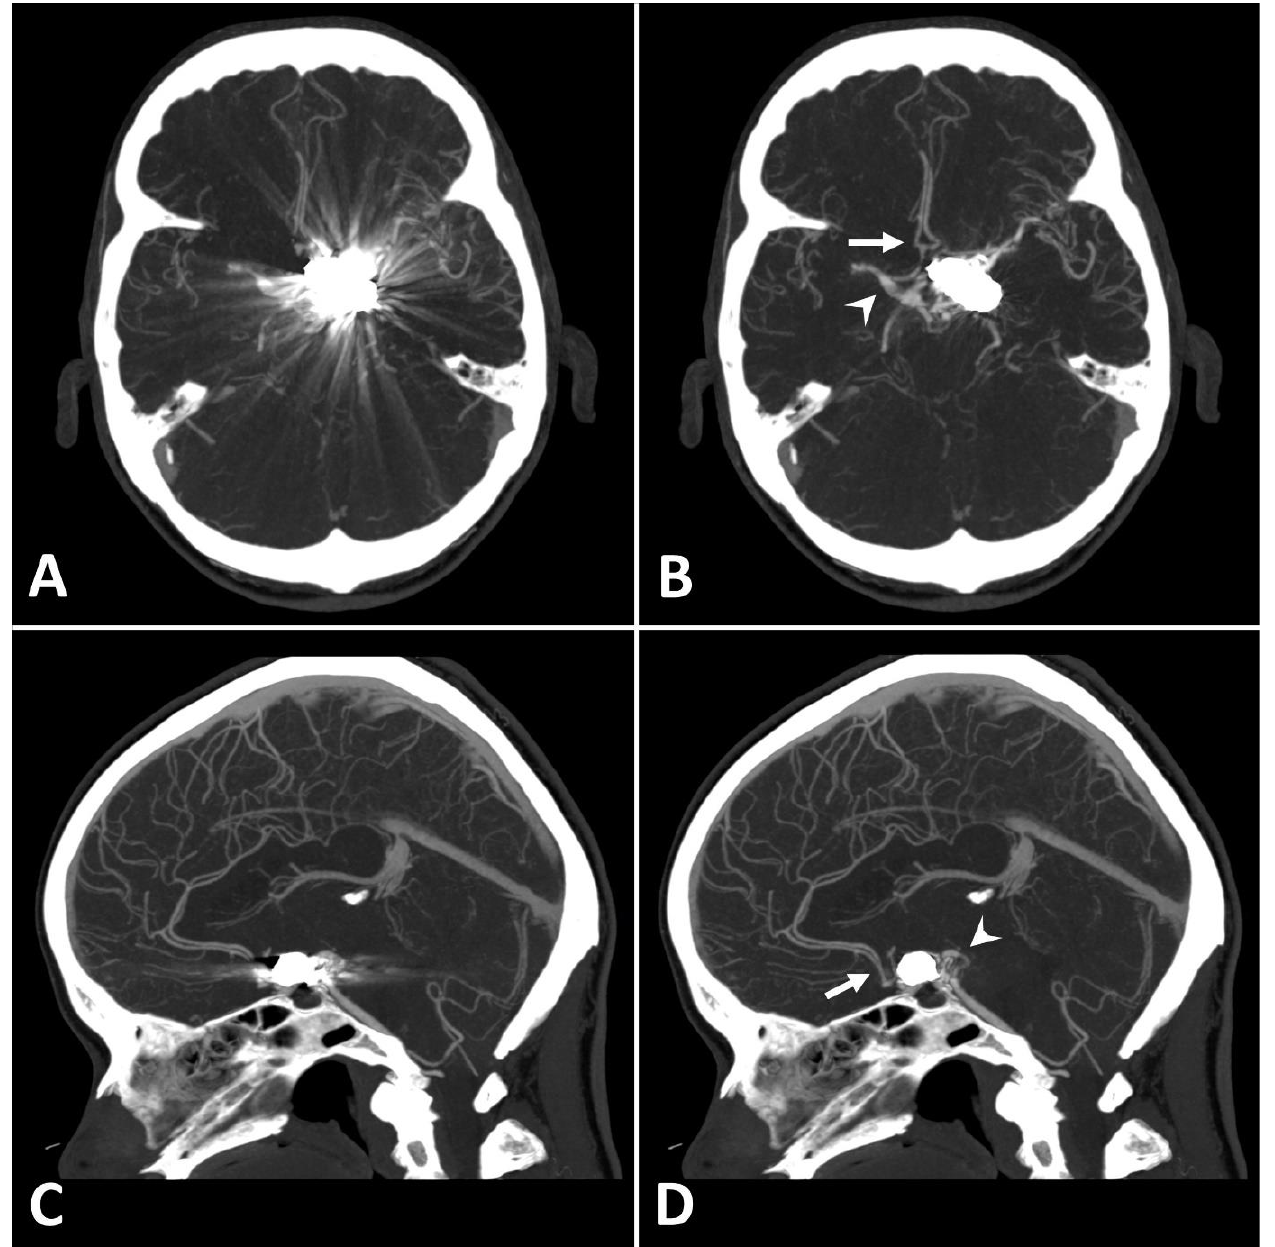
Figure 2. Exemplary follow up UHR-CT-angiography in axial ( A , B ) and sagittal ( C , D ) plane without ( A , C ) and with SEMAR ( B , D ) of a 56-year-old female after intracranial coil-embolization of a left sided posterior communicating artery aneurysm. All images were reconstructed as MIP (Maximum Intensity Projection) with 12.5 mm slice thickness. SEMAR significantly improves image quality, even in vessels directly adjacent to the coil package like the anterior communicating artery (white arrow in ( B )), the contralateral terminal carotid artery (arrowhead in ( B )), the anterior cerebral artery (white arrow in ( D )), and the posterior communicating artery (arrowhead in ( D )).